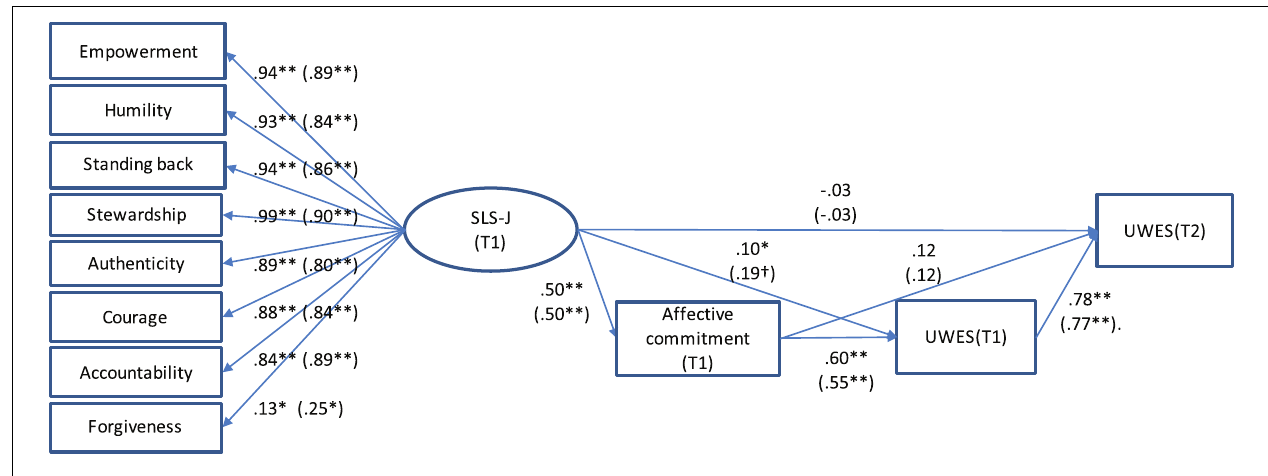
FIGURE 1 | Structural equation modeling (SEM) results for the hypothesized model. ∗∗ p < 0.01, ∗ p < 0.05., † p < 0.10. The hypothesized model using FIML ( N = 516) is shown. Original data ( N = 104) is shown in parentheses. T1 = Time 1, T2 = Time 2. UWES = Utrecht Work Engagement Scale. Hypothesized model using FIML ( N = 516): ( χ 2 (485) = 1031.921, p < 0.01, CFI = 0.925, TLI = 0.919, RMSEA = 0.047, AIC = 45943.903, BIC = 46406.728. the standardized indirect effect from SLS-J to UWES(T2) = 0.30 ( p < 0.01). Hypothesized model with original data ( N = 104): ( χ 2 (485) = 814.314, p < 0.01, CFI = 0.796, TLI = 0.778, RMSEA = 0.081, AIC = 10130.969, BIC = 10419.208. the standardized indirect effect from SLS-J to UWES(T2) = 0.36 ( p <